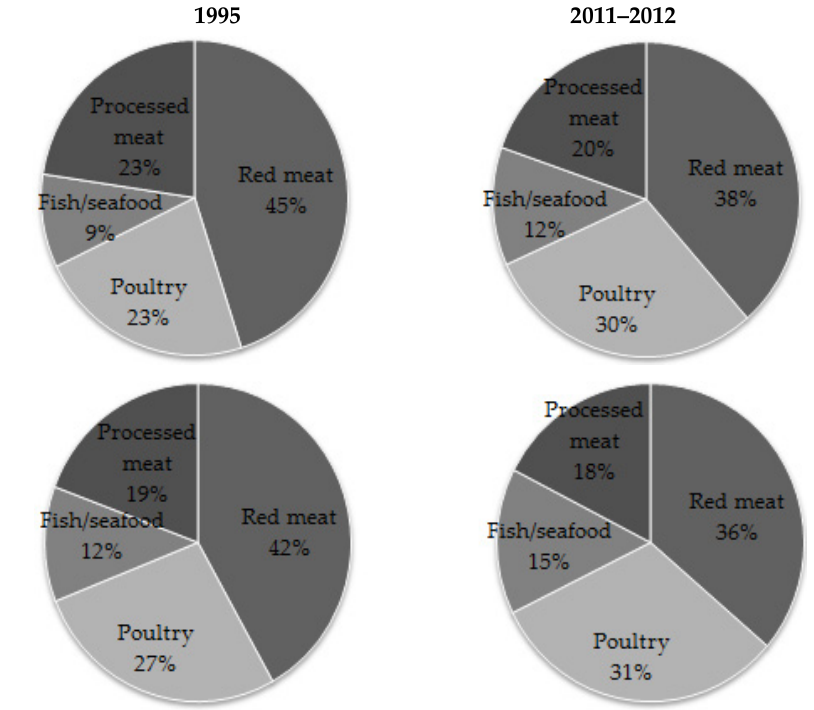
Figure 2. Per cent intake of different categories of meat in Australia, 1995 and 2011–2012.